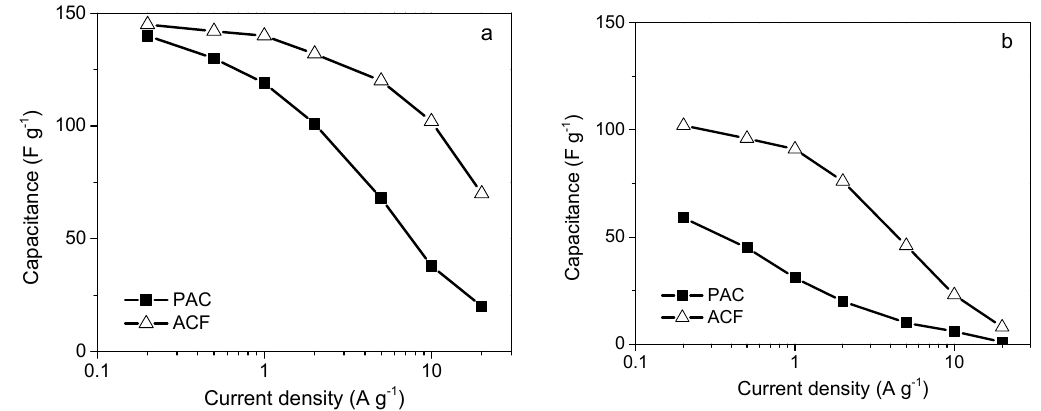
Figure 25. Rate capability of powdered activated carbon (PAC) and pulverized activated carbon fibres (ACF) in 6 mol L − 1 KOH ( a ) and 0.5 mol L − 1 K 2 SO 4 ( b ). Adapted from [179].